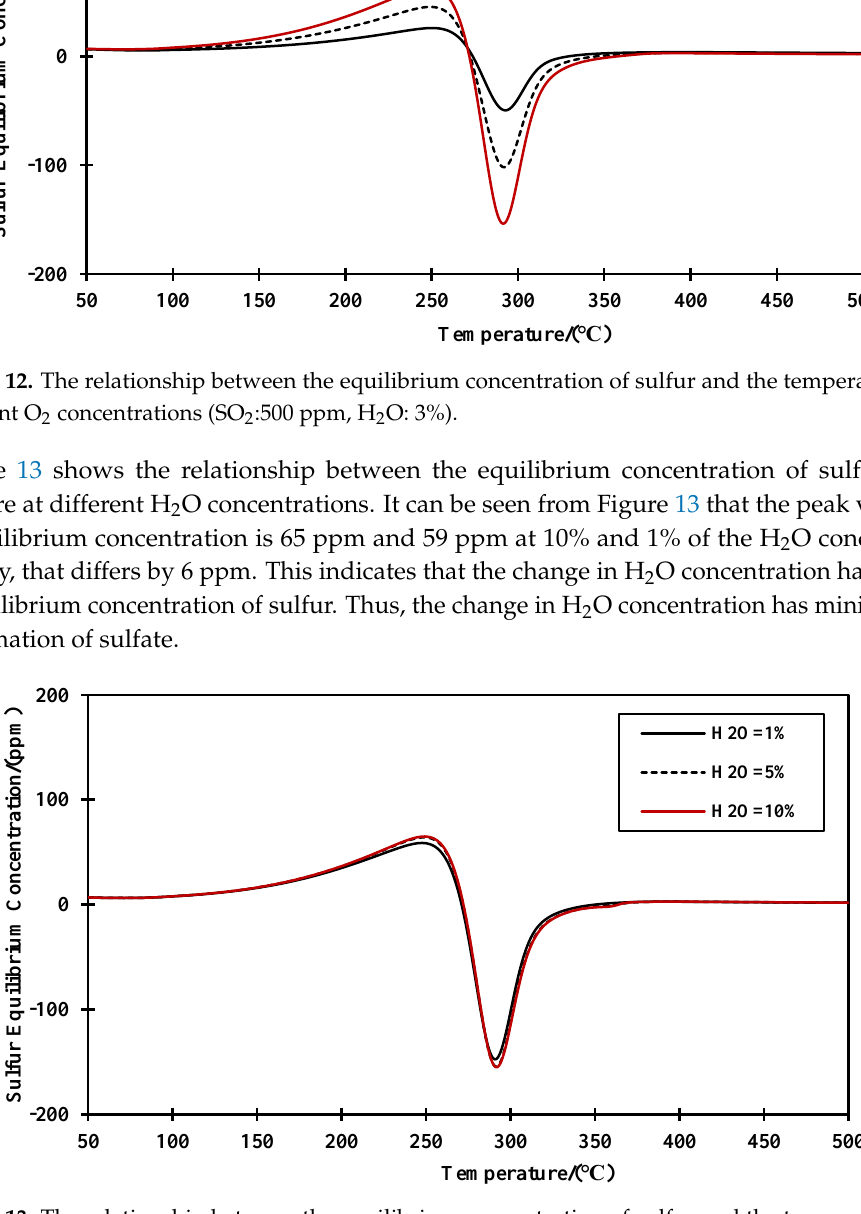
Figure 13. The relationship between the equilibrium concentration of sulfur and the temperature at different H 2 O concentrations (SO 2 :500 ppm, O 2 :15%).